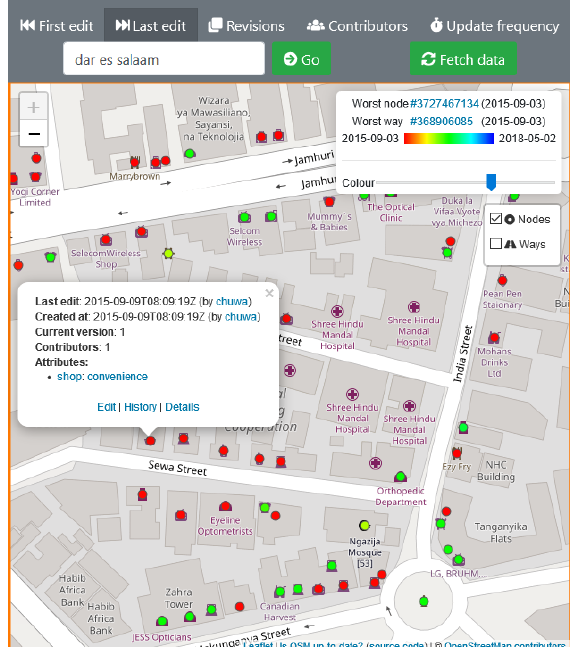
Figure 3. Screenshot of the “Is OSM up-to-date?” application showing a classification of nodes according to the date of last edit for an area in Dar es Salaam, Tanzania (map data © OpenStreetMap